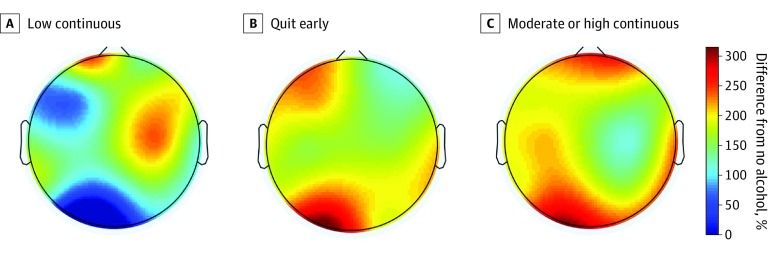
Main Effect of Alcohol on Electroencephalography PowerMain effect of alcohol at 4-6 Hz (theta) on newborn electroencephalography power representing the percent difference in power compared with no alcohol based on estimated marginal means.